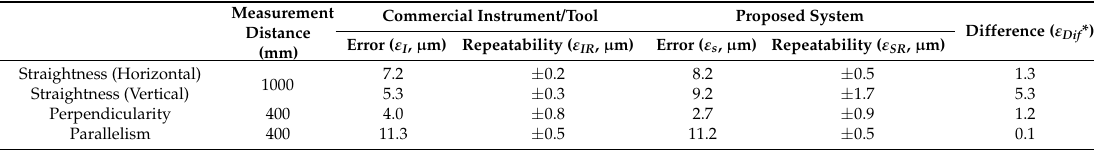
Table 4. Verification results of the proposed